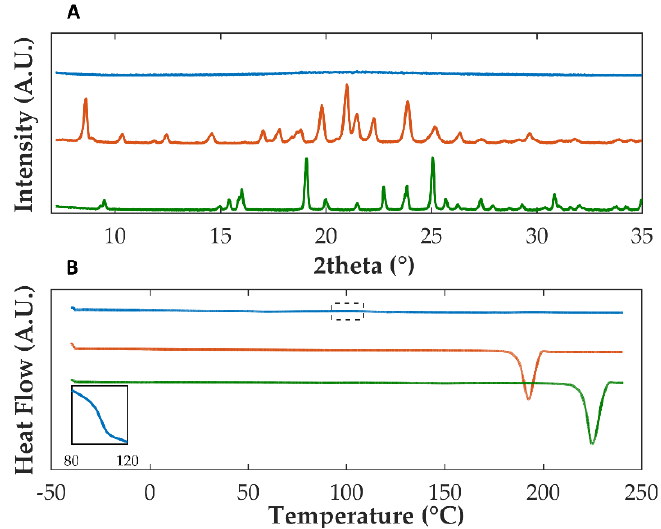
Figure 2. Diffractograms ( A ) and thermograms ( B ) of co-amorphous OLZ (blue), pure crystalline OLZ (orange), and pure crystalline SAC (green). The insert in thermogram B enlarges the glass transition region of co-amorphous OLZ.